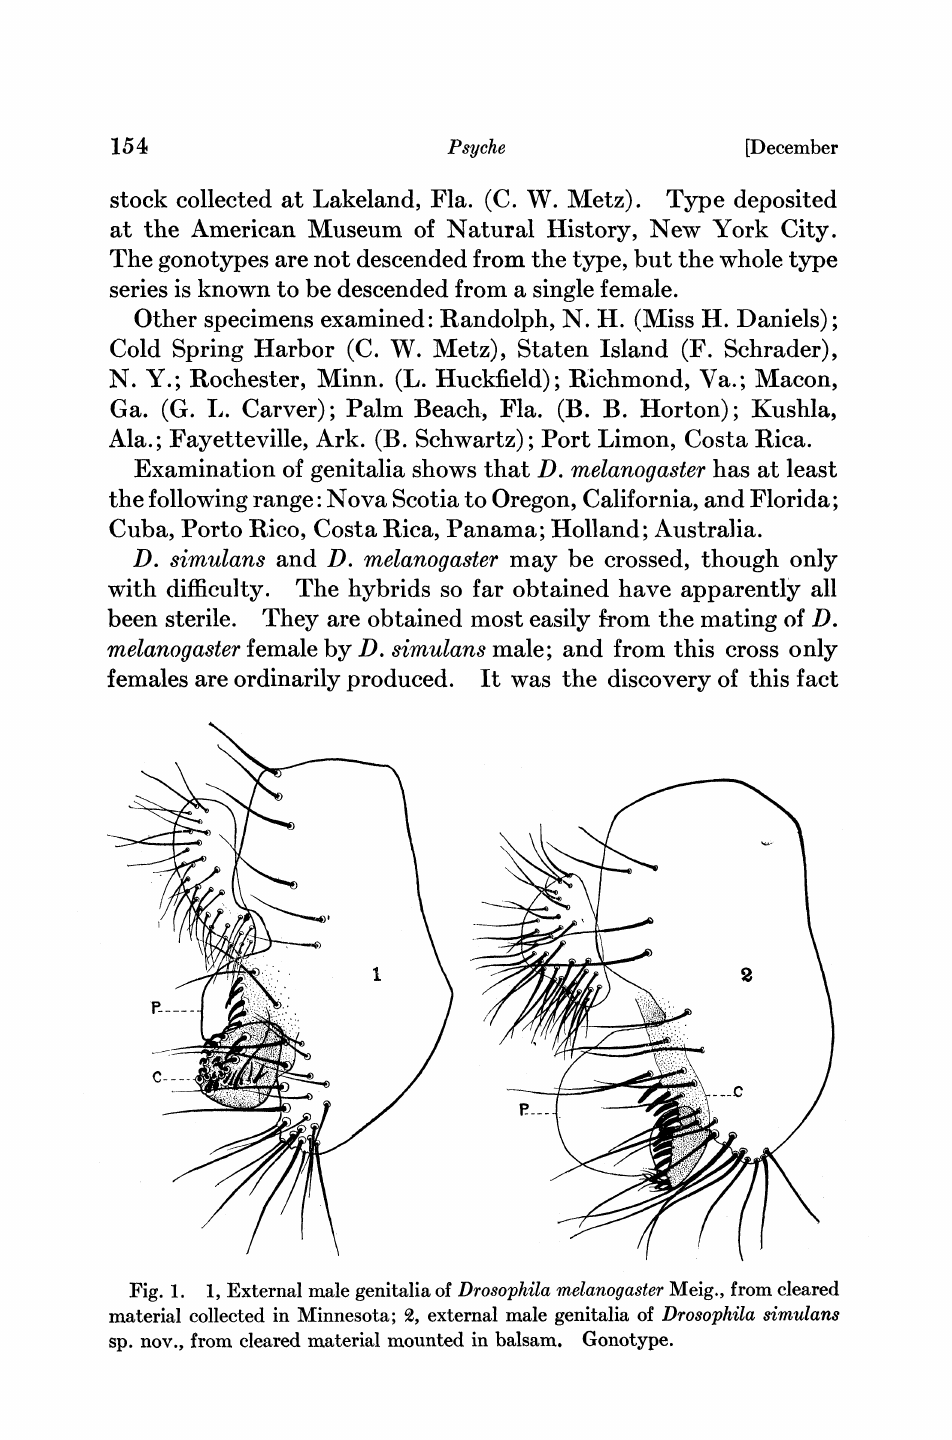
Fig. 1. 1, External male genitalia of Drosophila melanogaster Meig., from cleared material collected in Minnesota; 2, external male genitalia of Drosophila simulans sp. nov., from cleared material mounted in balsam.